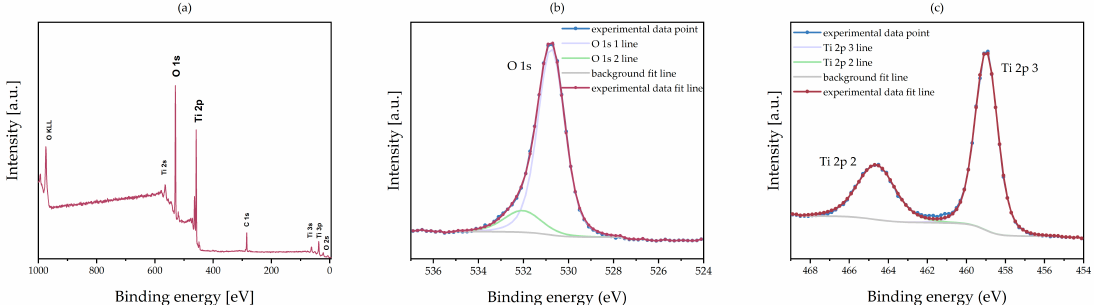
Figure 1. The XPS data plot of TiO 2 obtained by ALD on a glass substrate: ( a ) wide XPS spectra—only lines of O, Ti, and C were detected, C 1s binding energy (BE) 285.6 eV was used for energy scale calibration; ( b ) O1s experimental and fitting line; ( c ) Ti 2p experimental and fitting line.